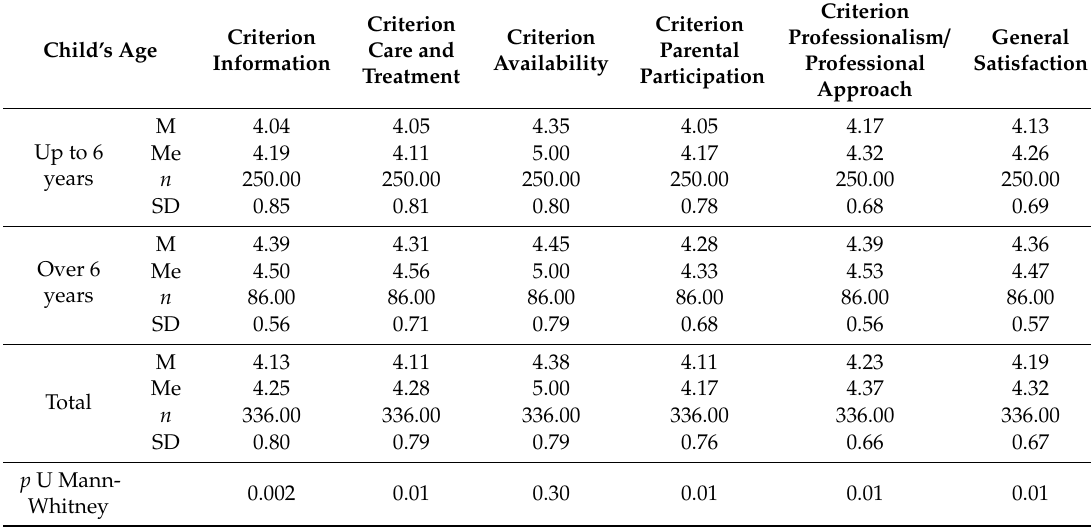
Table 2. Parental satisfaction with nursing team care and the age of hospitalised